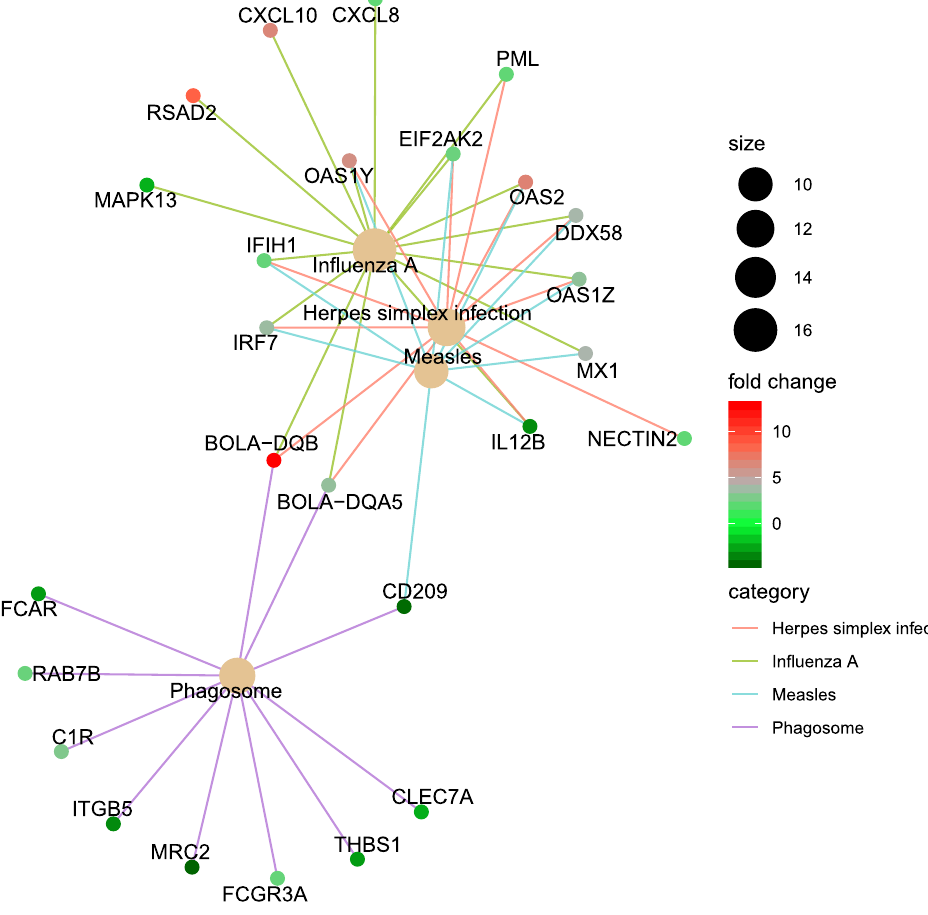
Figure 2. Cnet plot of enriched KEGG pathways ( P < 0.05, FDR < 0.05). This plot was produced in ClusterProfiler 12,15 based on the results of the “EnrichDAVID” 16,17 function. Category = the enriched KEGG pathway. Size = the number of differentially expressed genes which belong to the enriched KEGG pathway. Fold change = the fold change difference between the BRSV challenged calves relative to the control